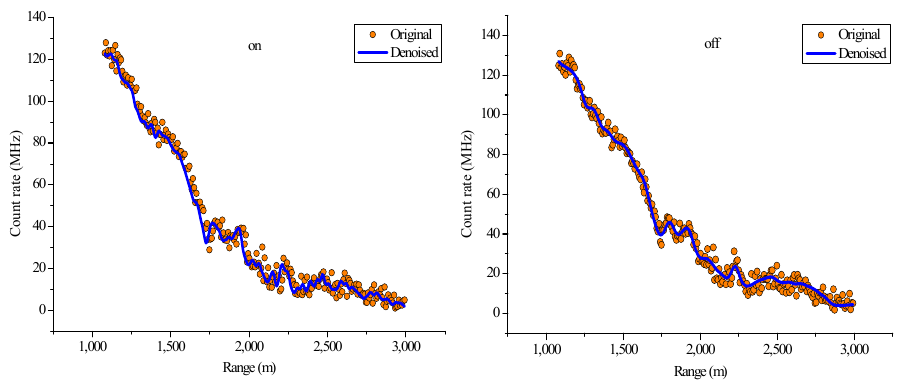
Figure 15. Original and denoised signals via LWT (( left ) on ‐ line wavelength; ( right ) off ‐ line wavelength).